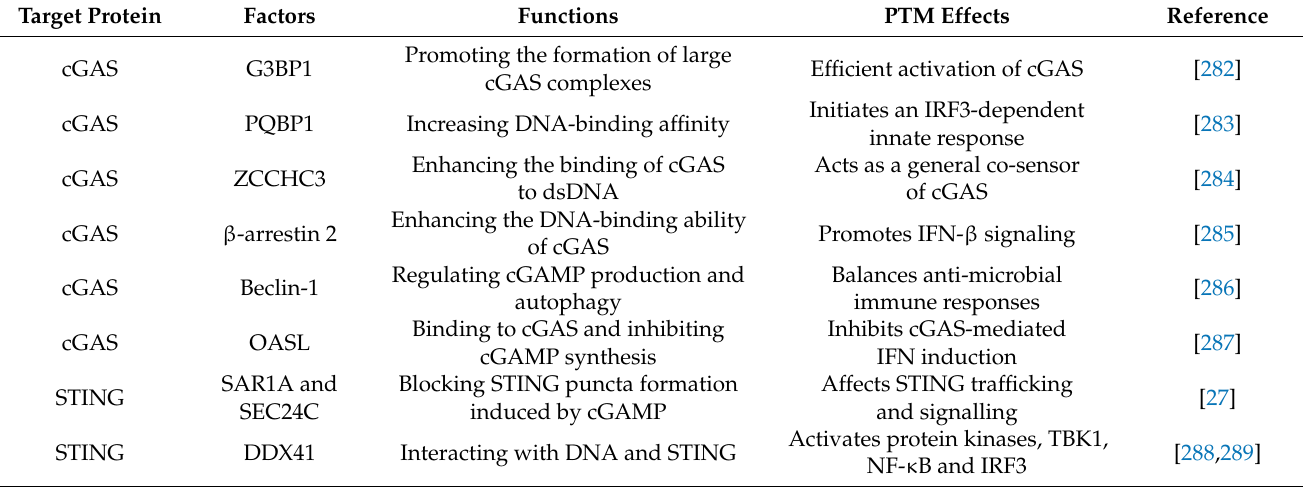
Table 2. Regulation of the cGAS-STING signaling by Direct Physical Interaction. Abbreviations: G3BP1: GTPase-activating protein-binding proteins 1; PQBP1: polyglutamine binding protein